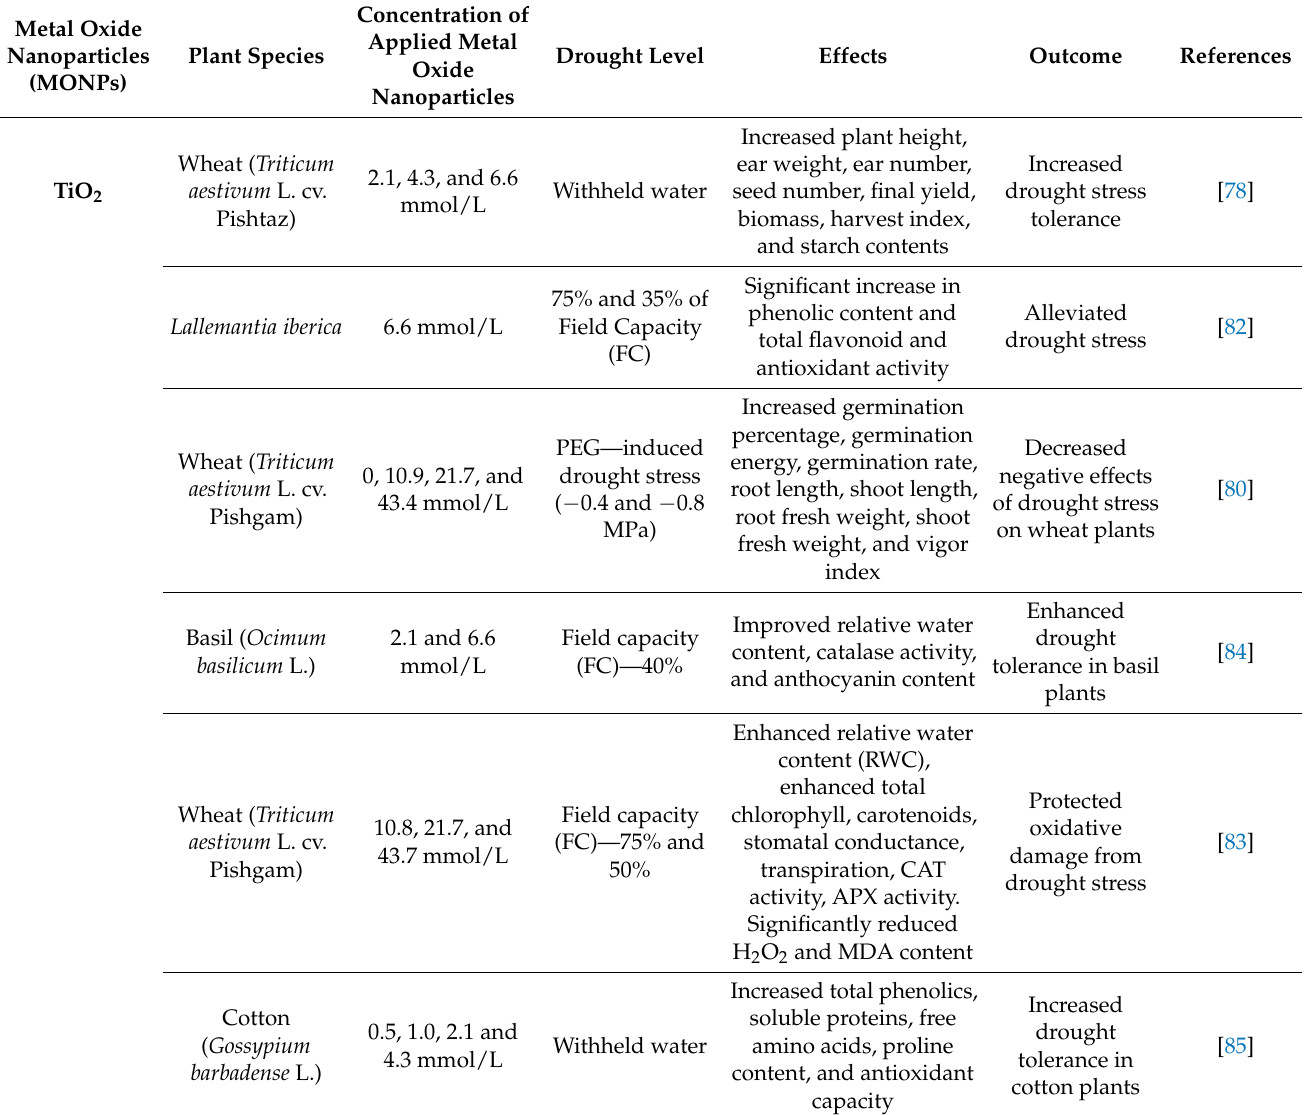
Table 2. Effects of application of metal oxide nanoparticles (MONPs) on drought stress in crop plants. Metal Oxide